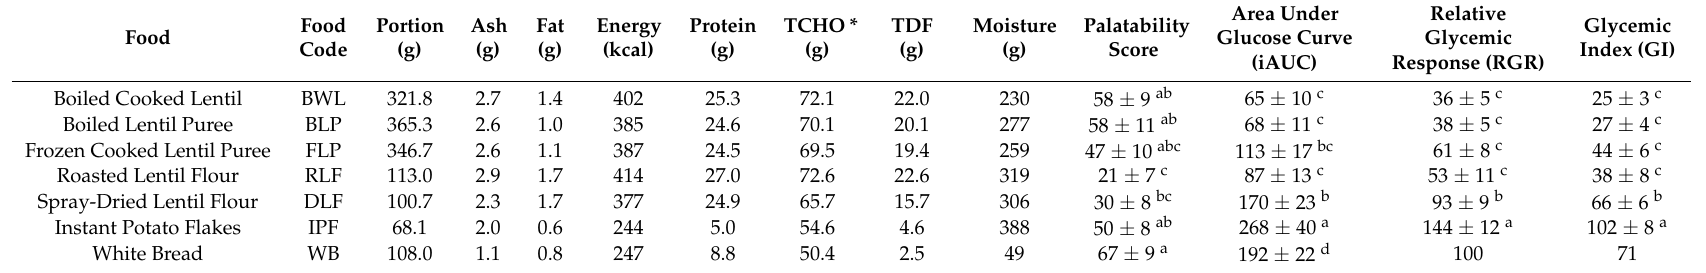
Table 2. Nutritional composition of whole lentil products and measures of glycemic